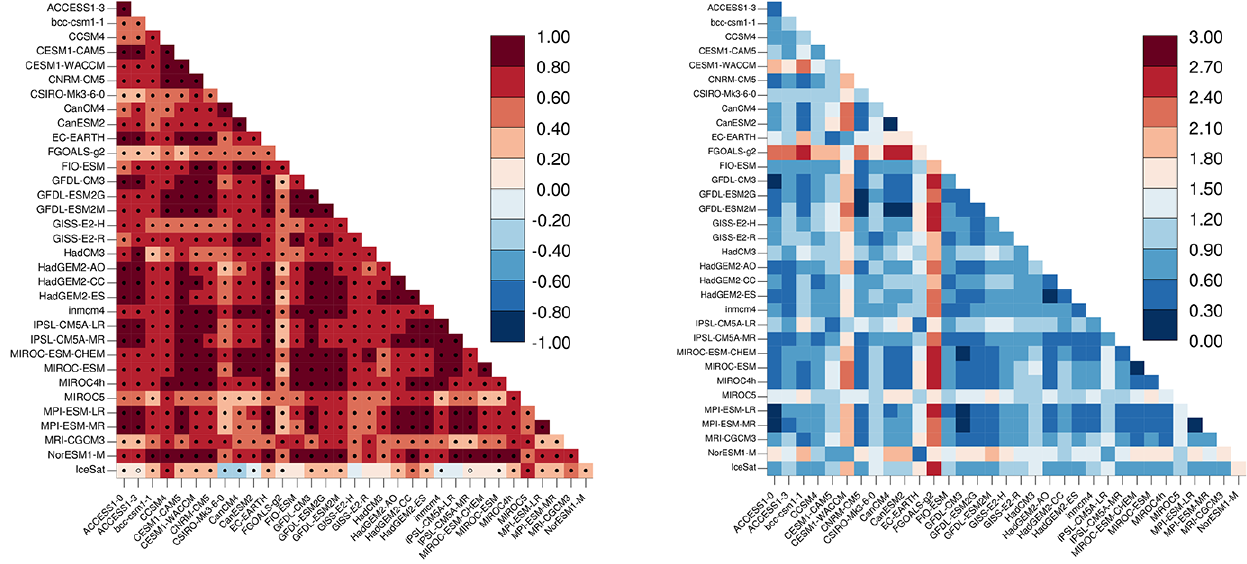
Figure 5. Spatial pattern correlations (top) and root-mean-square error (RMSE) (bottom) of ice thickness in 27 CMIP5 models and ICESat. Filled and empty circles indicate correlations that are significant at the 99 and 95% level.